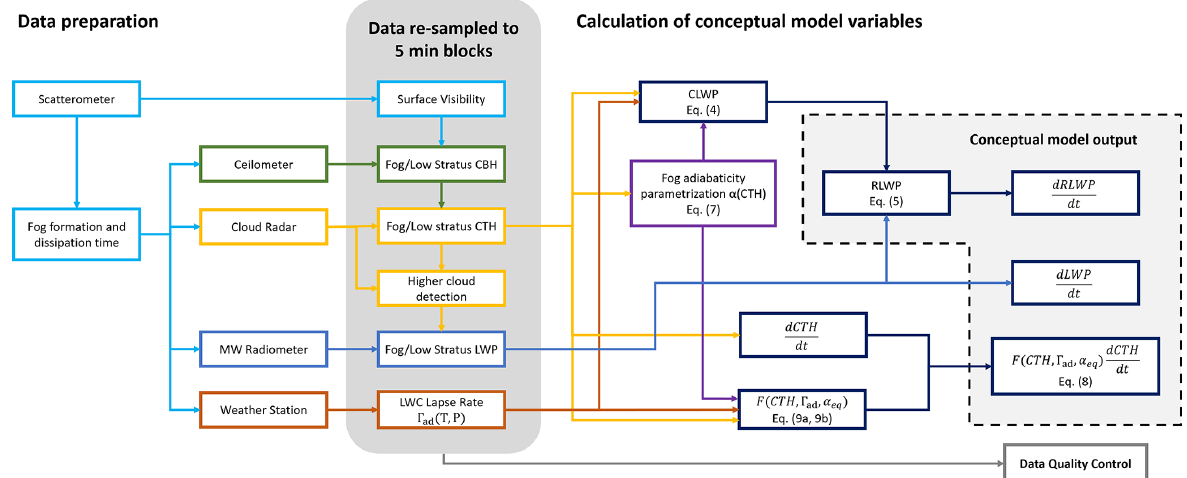
Figure 2. Summary of the data treatment and calculation methodology. The procedure can be separated into three main stages: first, data preparation consists of identifying fog periods from historical visibility measurements and of gathering raw instrumental information for these periods. Second, data are re-sampled and homogenized into 5min time blocks. First-order products such as fog CTH and LWP, among others, are calculated. Third, the data treated in the second stage is used to calculate conceptual model variables. An additional data quality control stage is included, to check if the variables of each identified period were retrieved under reliable operating conditions of the